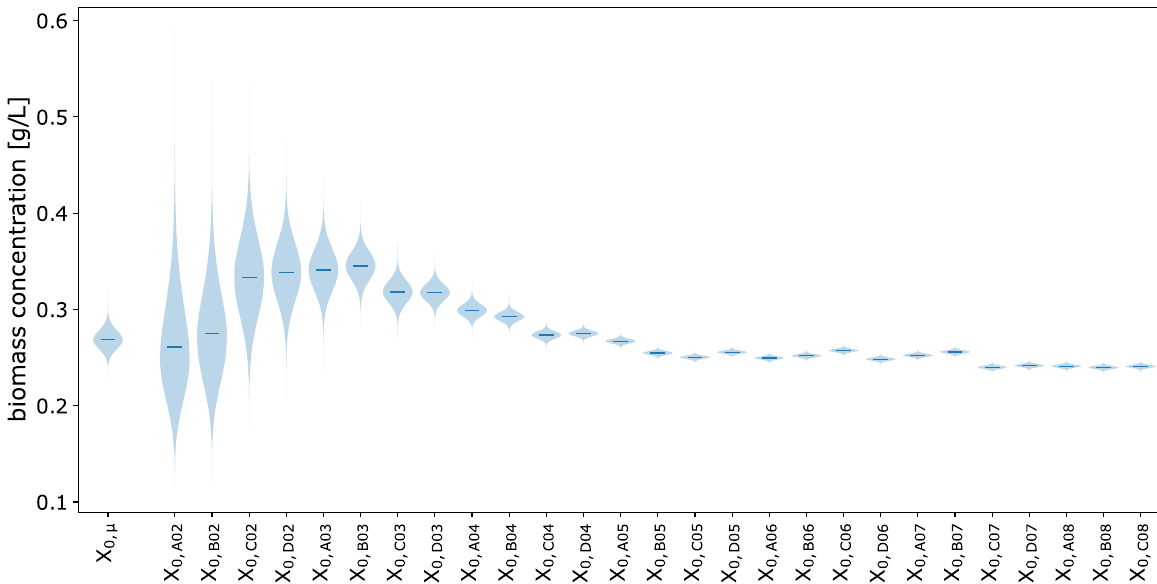
Fig 15. Posterior group mean and well-specific initial biomass concentrations X 0 . Variability between the growth curves in separate wells is described by well-specific initial biomass concentrations X 0,well . Their posterior probability distribution is wide if the well was sacrificed early (left) and narrows down with the number of observed time points (right). Their common hyperprior (a.k.a group mean prior) X 0, μ for the mean of each X 0,well was updated to a posterior with HDI 90 % ¼ ½ 0 : 250 ; 0 : 288 � g . X 0 ; m L